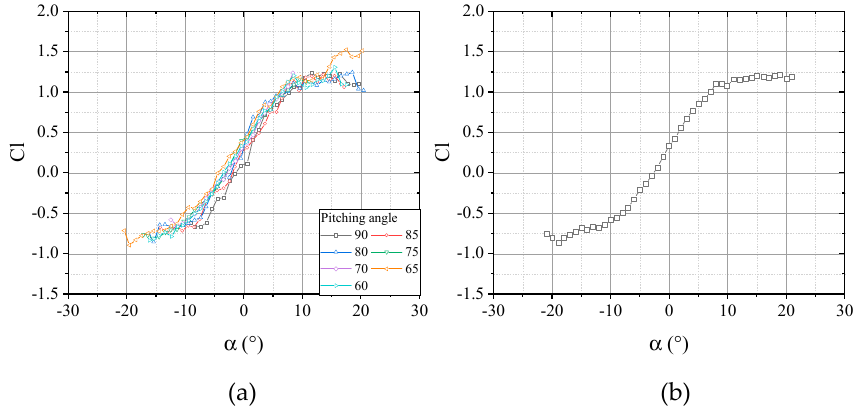
14 of 20 Figure 15. Instantaneous lift coefficients at r/R = 0.64 with different pitching angles. However, it is difficult to determine relationship between lift coefficient and angle of attack, because each angle of attack corresponds to a number of lift coefficient values. An angle-averaged method was employed to process the multi-value lift coefficient at one angle of attack to single-value. In the angle-averaged method, all the angles of attack were divided into several data sets with the length of 1°. Each angle of attack set is α k = [ α k1 ,  α k2 ,… α kn ], and the corresponding lift coefficient dataset is Cl k = [ Cl k1 , Cl k2 ,… Cl kn ] . Then the lift coefficients and angles of attack in each dataset were averaged to obtain the angle-averaged lift coefficient and angle of attack, as shown in Equation (10),